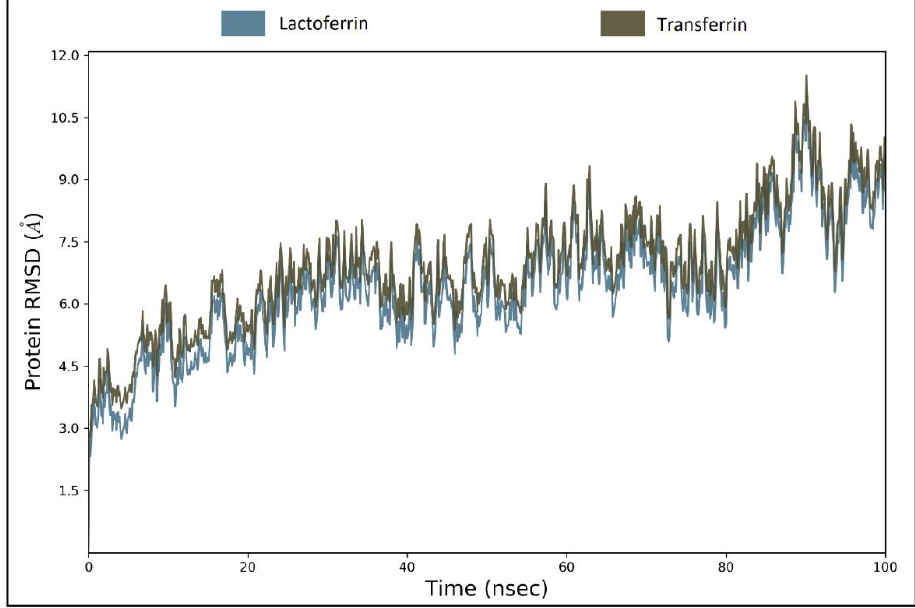
Figure 4. Protein–protein (Lf-Tf) RMSD plot. Figure 4. Protein – protein (Lf-Tf) RMSD plot.